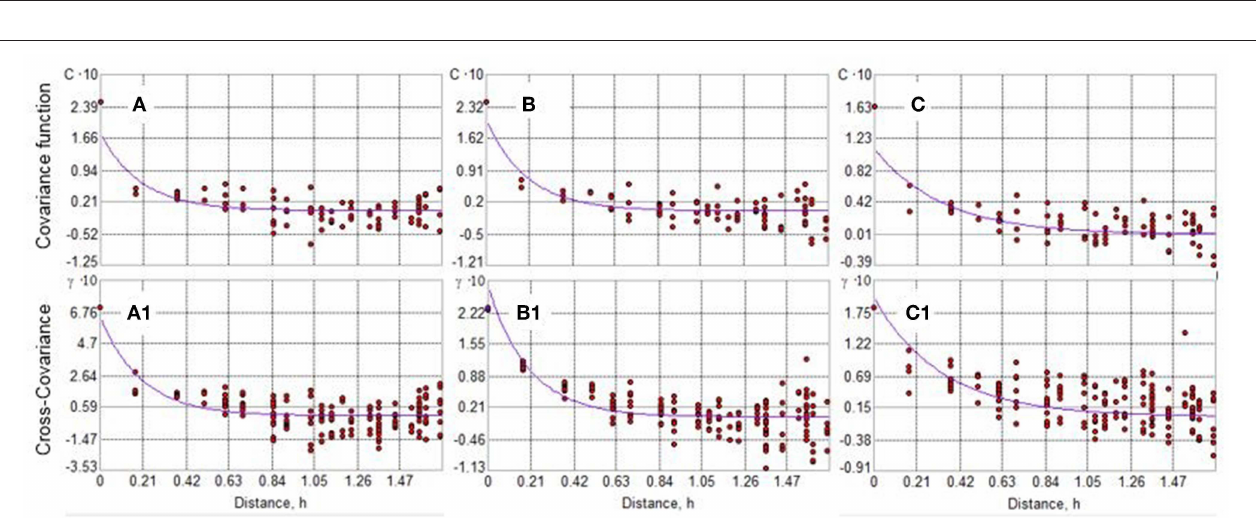
FIGURE 2 | Isotropic neighboring circle for erosivity density during (A) August, (B) September, and (C) October. The colured bands in the corner represent the patterns of station-points inside of any neighboring circle with the related percentage weighted given for any data-points.